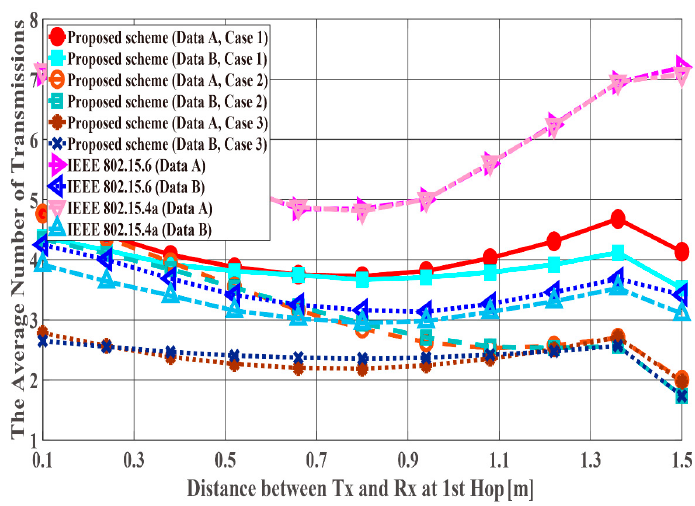
Figure 16. Average number of transmissions with constant (cid:1856) (cid:2870)(cid:3035)(cid:3042)(cid:3043)(cid:3046) .